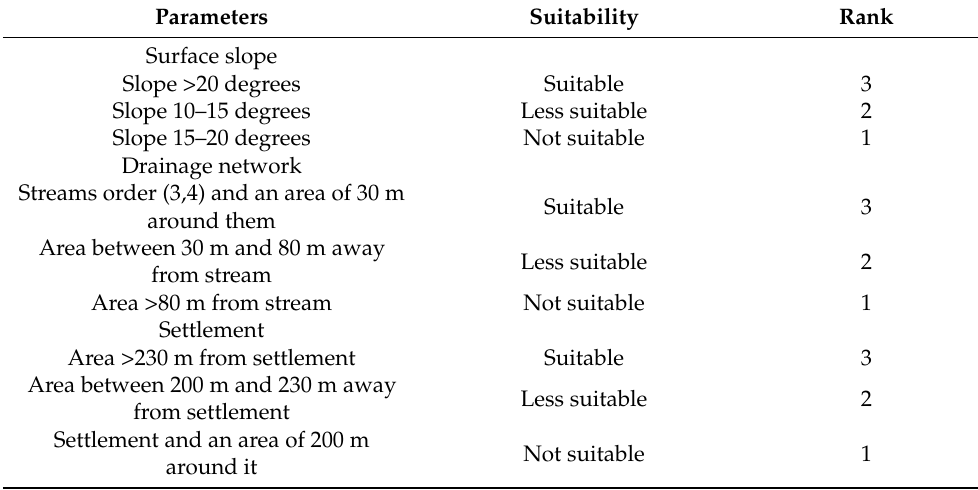
Table 4. Categorization and ranking for selecting suitable sites for gully plugs. Surface slope, drainage network, settlement, roads, runoff volume, and rainwater harvesting results are classified into three categories—suitable, less-suitable and not-suitable categories—according to the guidelines of